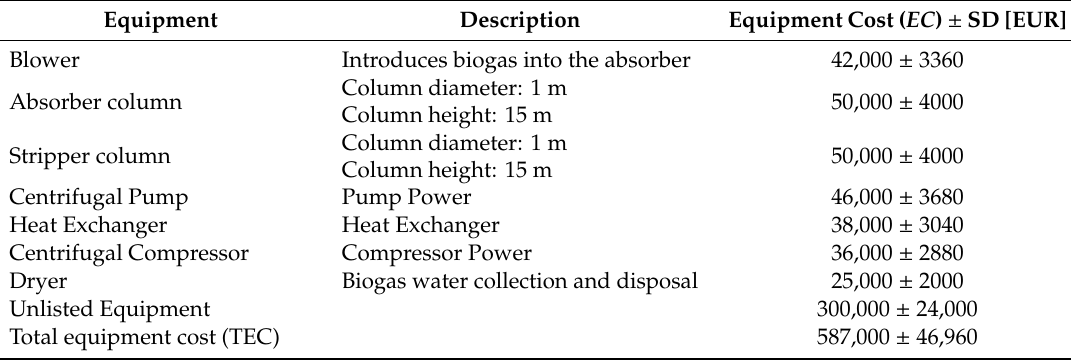
Table 6. Estimated costs of equipment of biogas upgrading